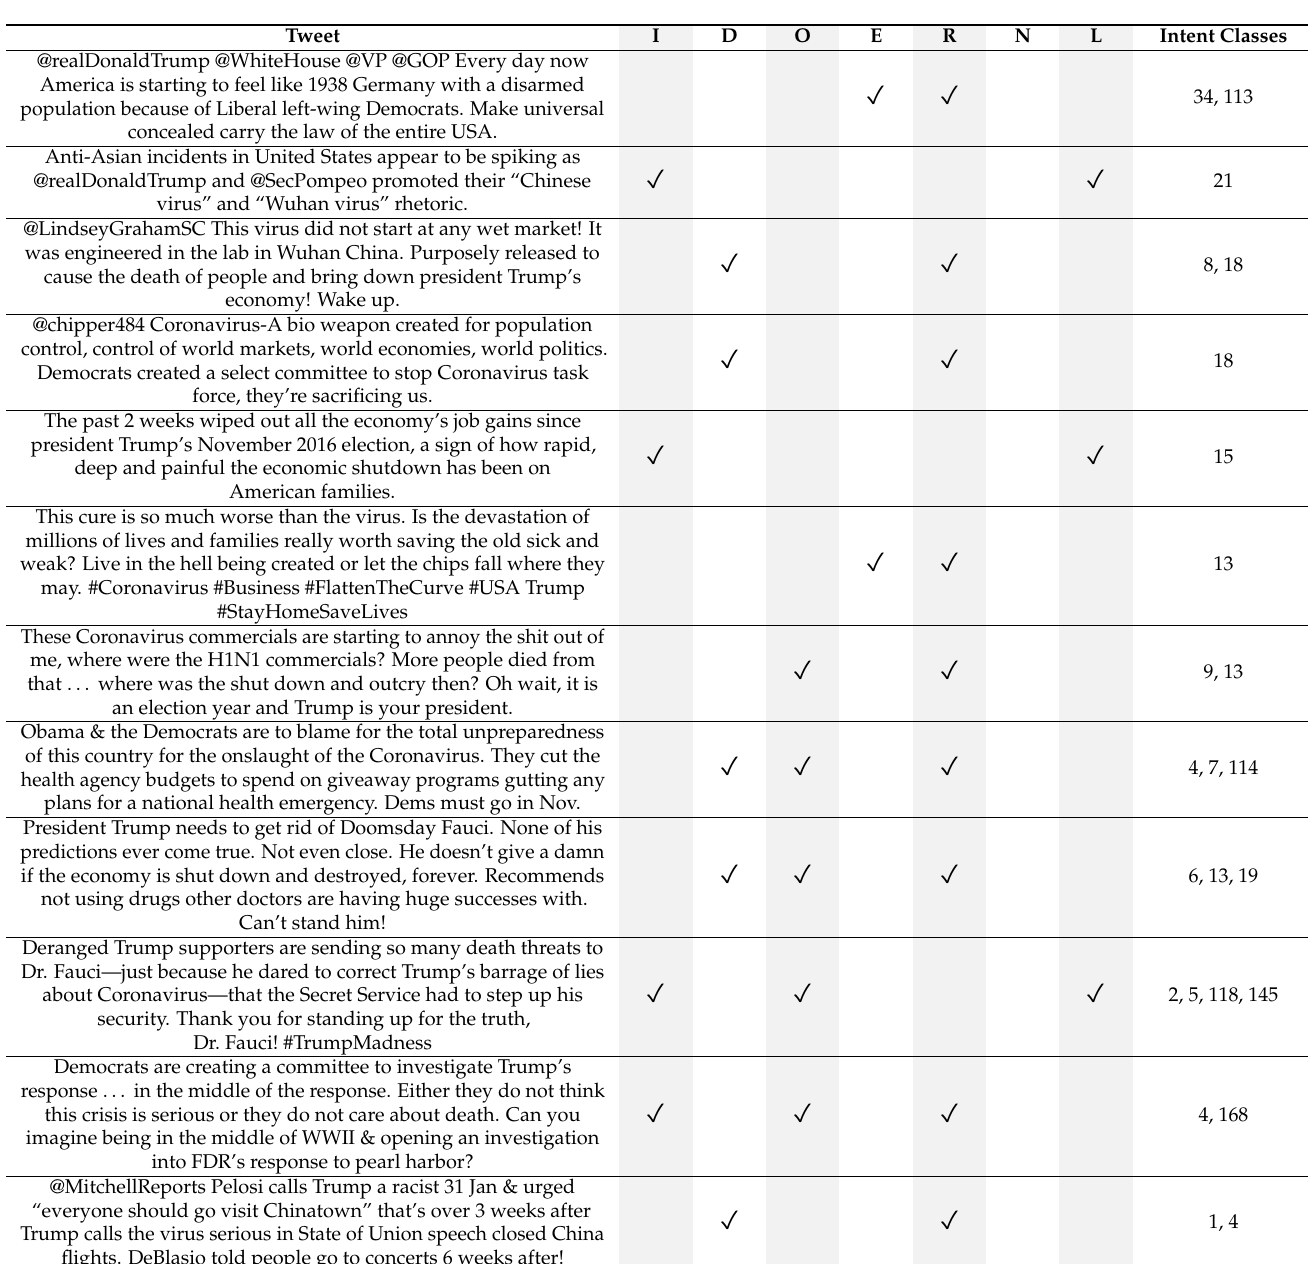
Table 2. Example Tweets and their classes: I stands for information, D for disinformation, O for opinion, E for extreme opinion, R for rightist, N for neutral, and L for leftist.